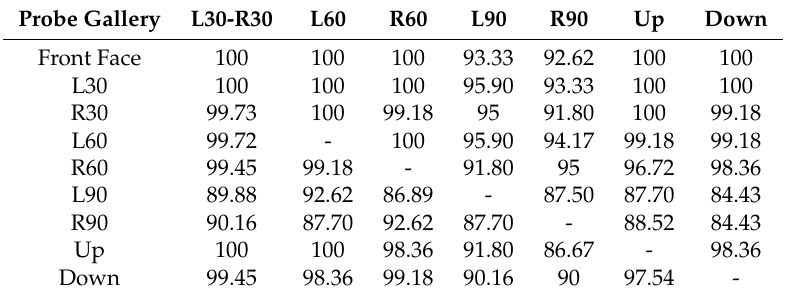
Table 4. Rank-1 identification accuracies on CASIA-3D FaceV1 under pose rotations. R30 represents facial images under yaw rotations of 30 degrees, similar to R60 and R90. L30 represents yaw rotations of − 30 degrees, similar to L60 and L90. Up and Down represent pitch rotations of upward and downward. Probe